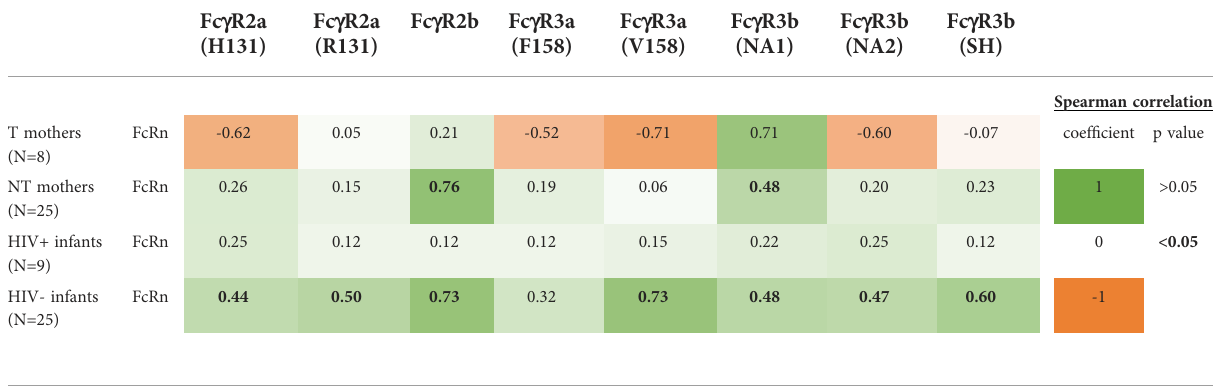
TABLE 1 Correlation between gp140-speci fi c FcRn-reactive plasma IgG and gp140-speci fi c FcR-reactive plasma